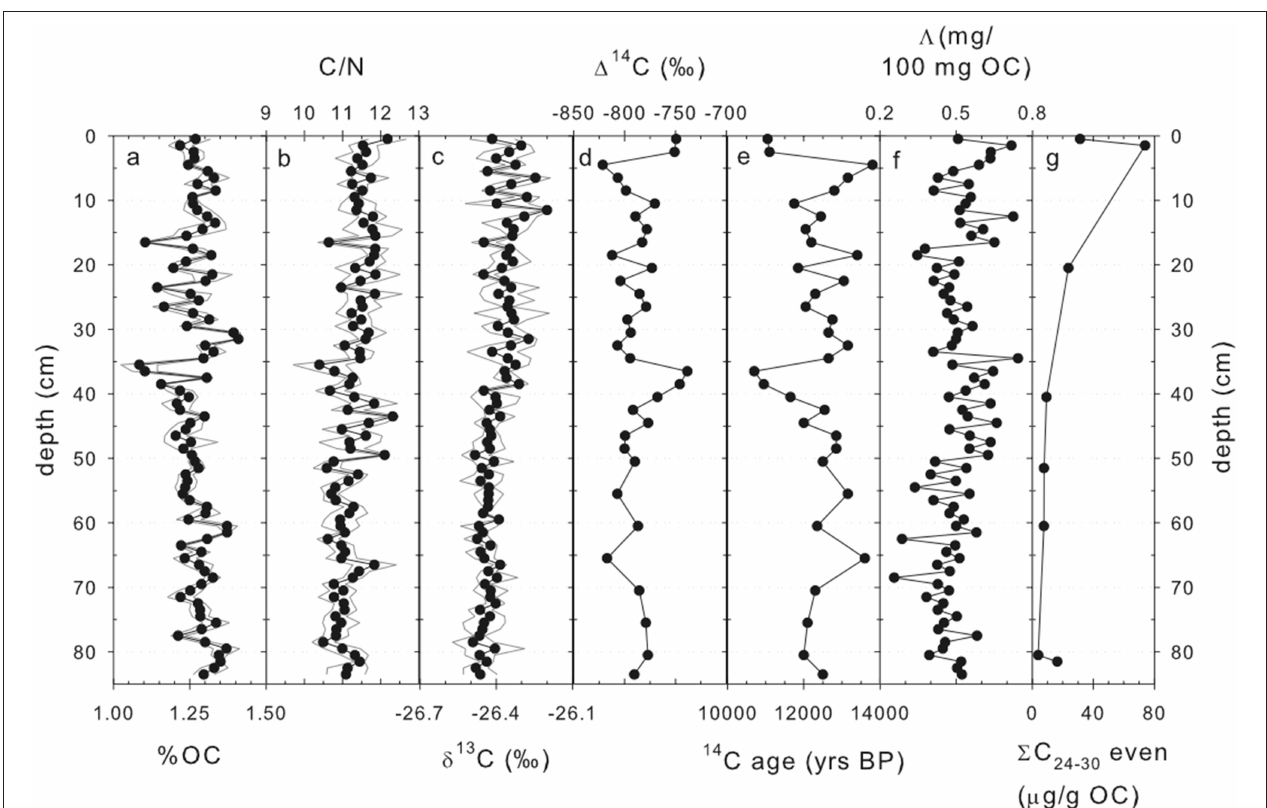
FIGURE 4 | Organic geochemical data for lake LD-1 down-core sediment horizons, with (A) %OC, (B) atomic C/N ratios, (C) stable carbon isotopic ( δ 13 C) ratios, (D) radiocarbon ( 1 14 C) signature, (E) radiocarbon age (years BP), (F) total lignin yield per mass OC, and (G) sum of even long-chain (C 24 –C 30 ) fatty acids per mass OC. The gray lines in plots a-c show ± 1 standard deviation. The analytical uncertainty for 1 14 C and 14 C-age are smaller than the data points.